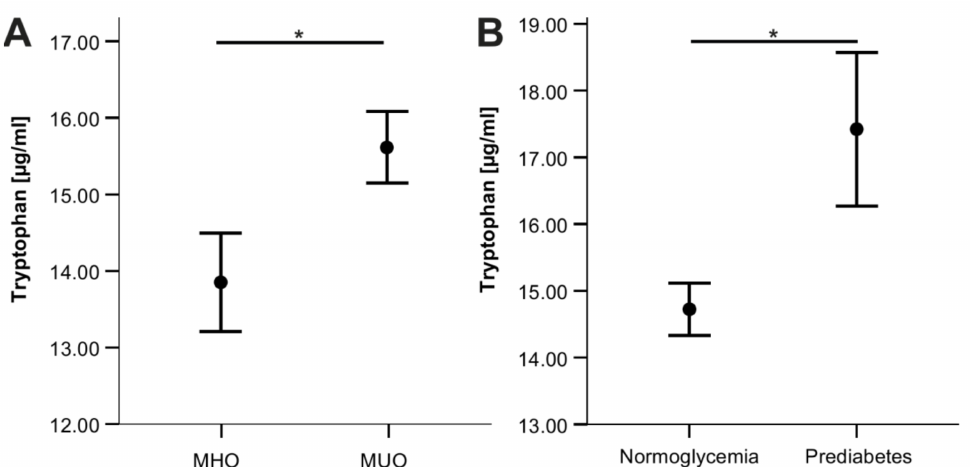
Figure 2. Tryptophan levels of different metabolic conditions. ( A ), metabolically unhealthy (MUO) vs. healthy obesity (MHO; p = 0.04). ( B ), prediabetes vs. normoglycemic controls ( p = 0.04). Diagrams show means ± standard error. * p <